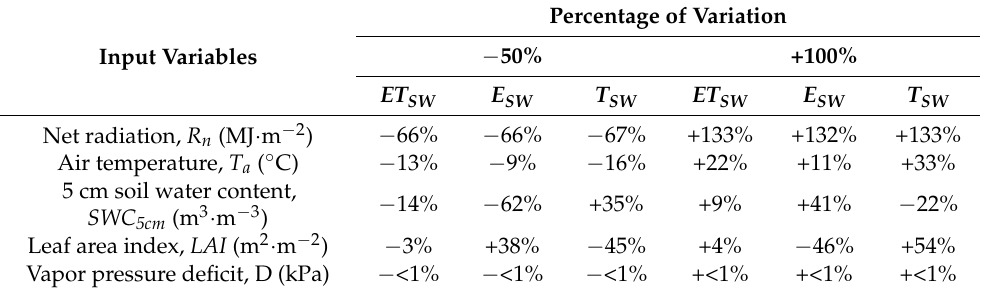
Table 4. Effects of net radiation ( R n ), air temperature ( T a ), 5 cm soil water content ( SWC 5cm ), vapor pressure deficit ( D ) and leaf area index ( LAI ) on ET , E , and T in the growing season of 2007 and 2008 for the degraded